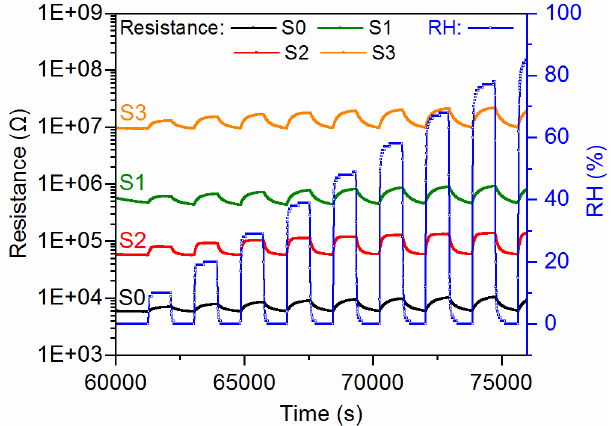
Figure 8. The response and recovery times at 300 °C for CuO:Ga 2 O 3 films (sample S1) with ~4% at. Ga at the exposition to 0.25 ppm acetone.